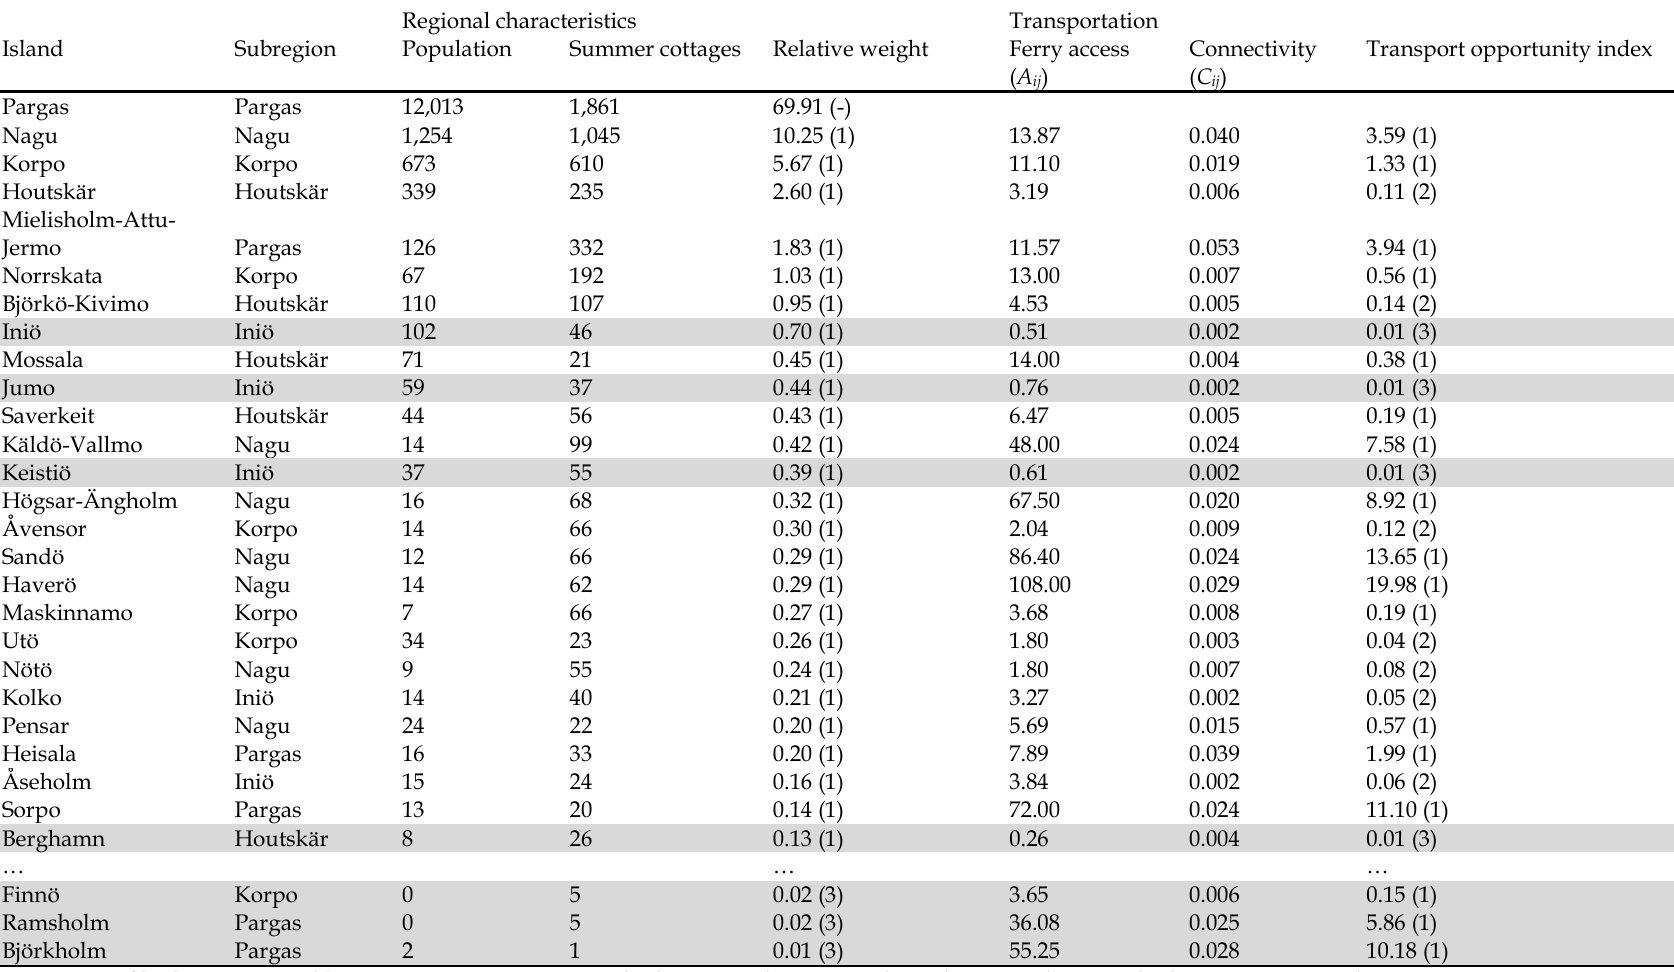
Table 2.The relative weights and transport opportunity scores of selected islands in the Pargas